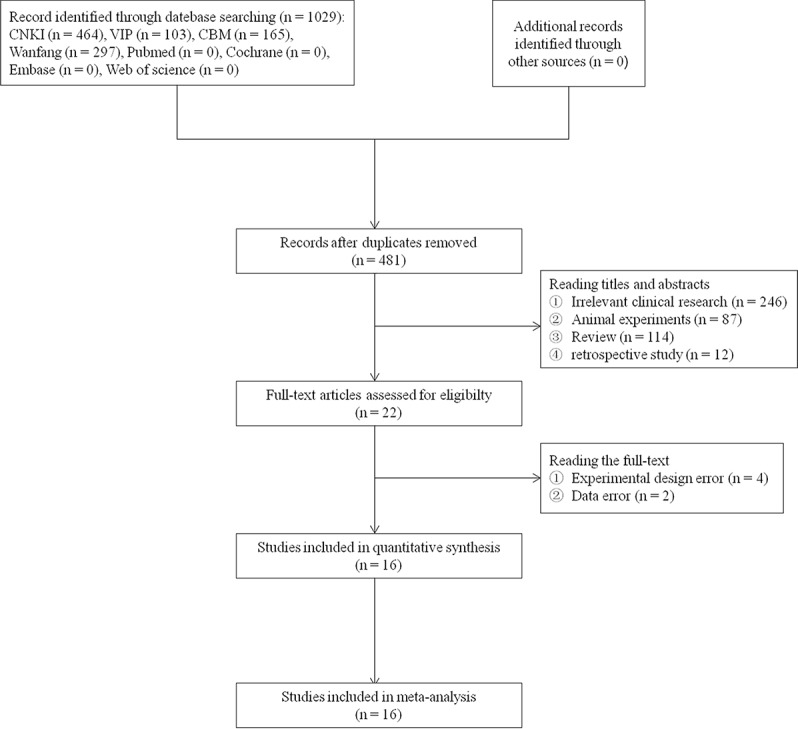
Flow diagram of the literature selection.